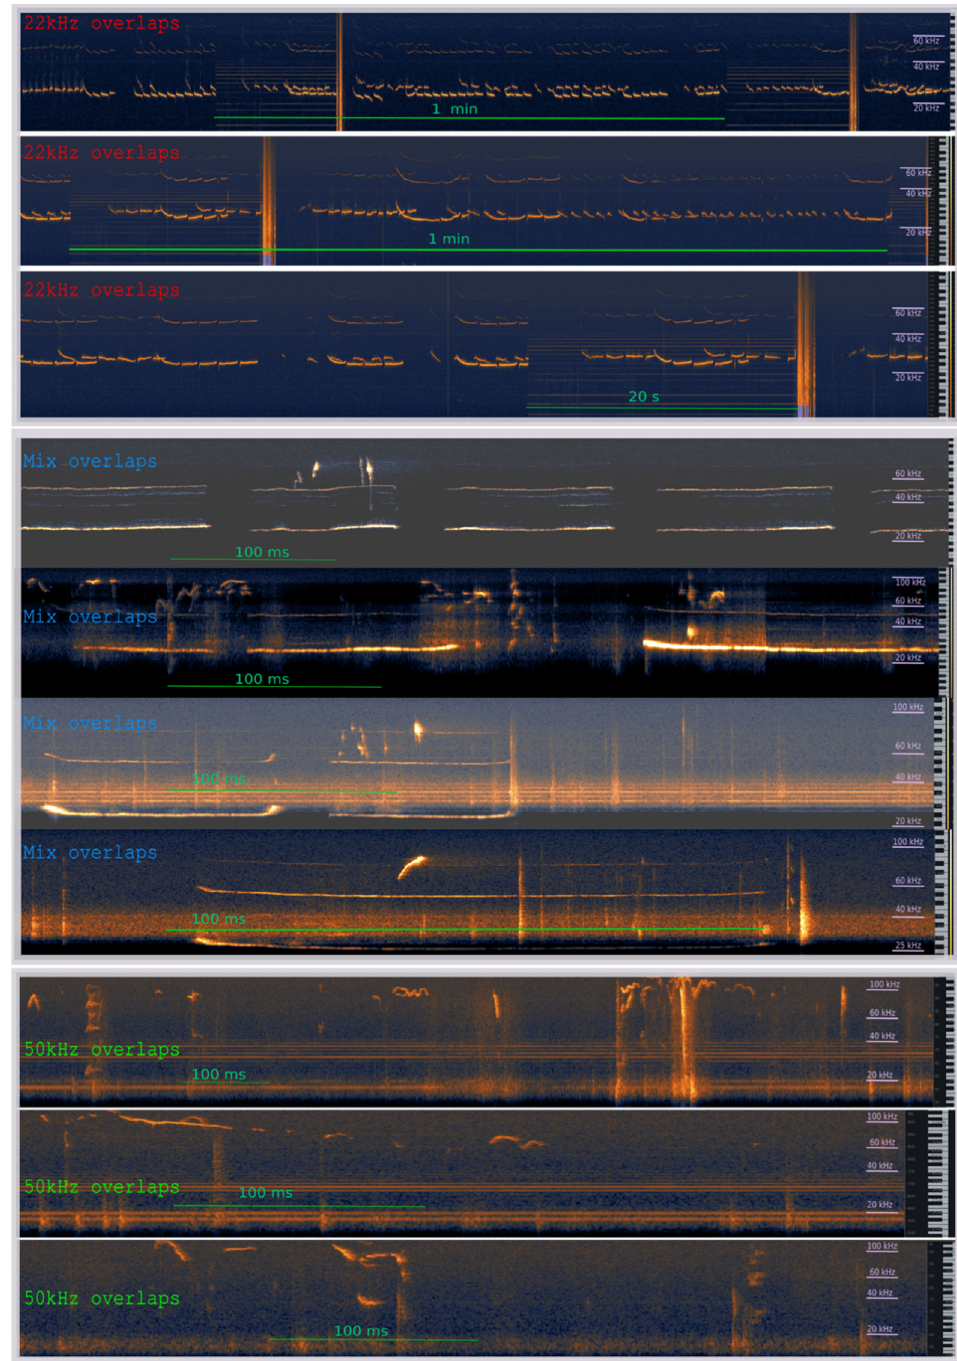
Figure 8. An example of overlapping ultrasonic vocalization presented on a spectrogram.